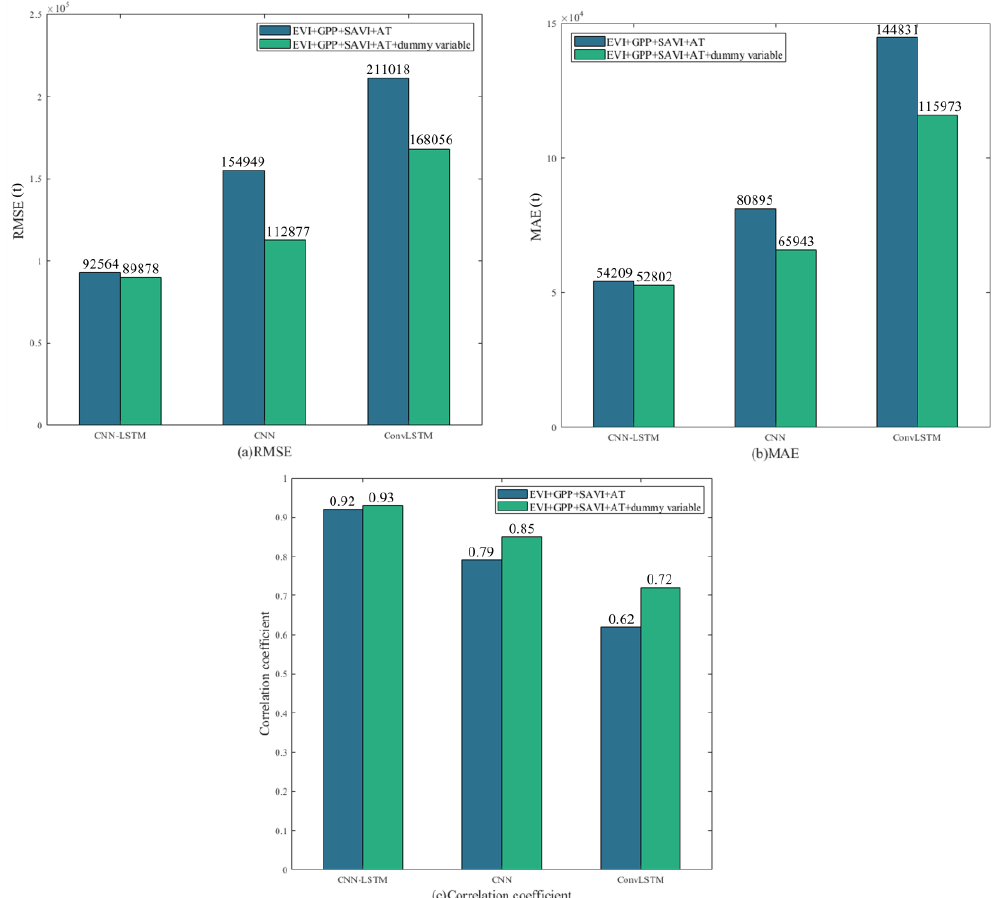
Figure 8. Comparative experimental results of the three groups of models regarding the dummy variable. ( a ) is the comparative result of RMSE after adding a dummy variable. ( b ) is the comparison result of MAE after adding a dummy variable. ( c ) is the comparison result of the correlation coefficient after adding a dummy variable.